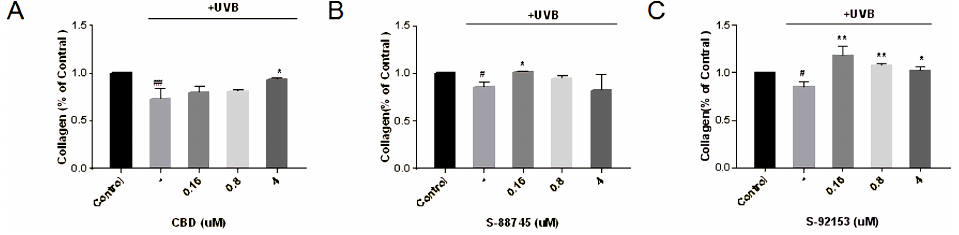
Figure 12. Production of ( A ) CBD, ( B ) S-88745 and ( C ) S-92153 on UV-stimulated collagen in HFF ‐